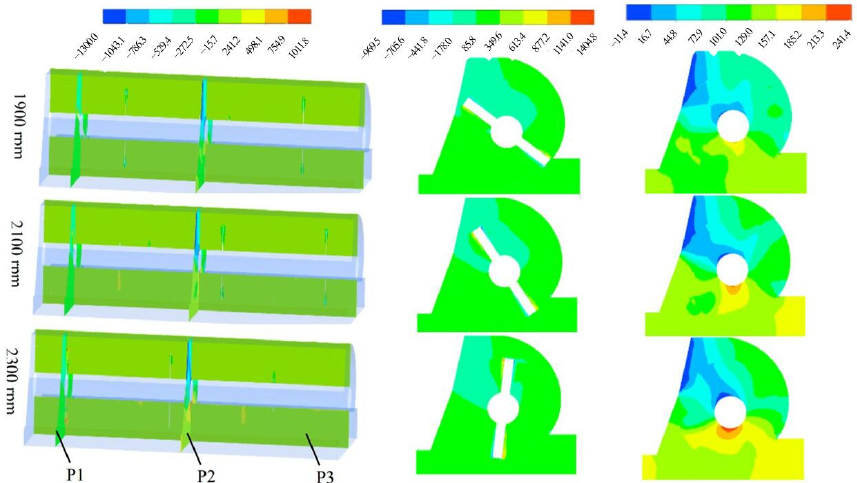
Figure 6. The pressure of the chopping chamber section under different rotating velocities of the chopping blade shaft (t = 2 s) [79]. chopping blade shaft (t = 2 s)